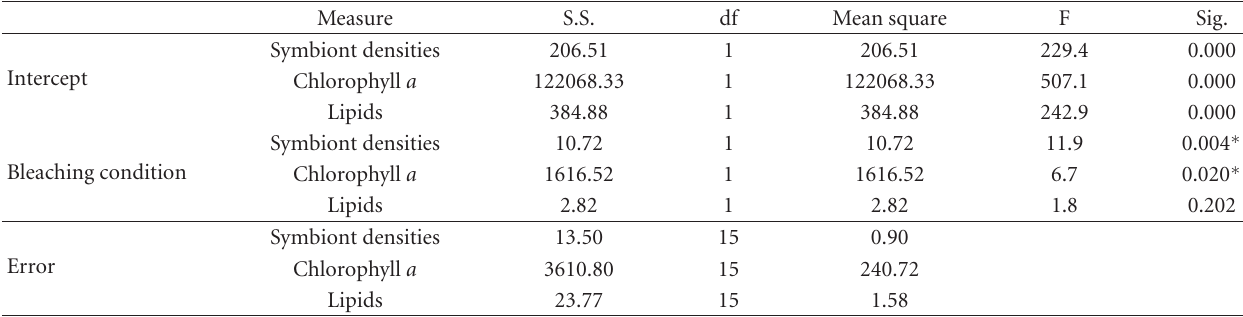
Table 5: The between-subject e ff ects of repeated-measures multivariate ANOVA showing the significant e ff ect of condition (bleached or unbleached in February 2006) on the symbiont densities and algal chlorophyll a content of Acropora millepora colonies. ∗ indicate significant results.